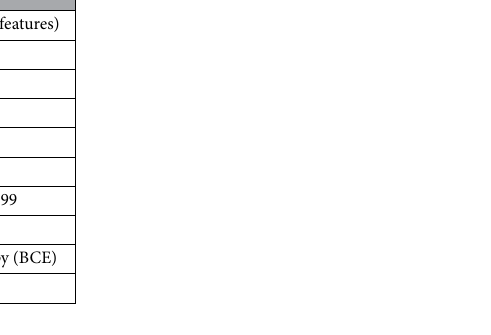
Table 5. AE implementation details.